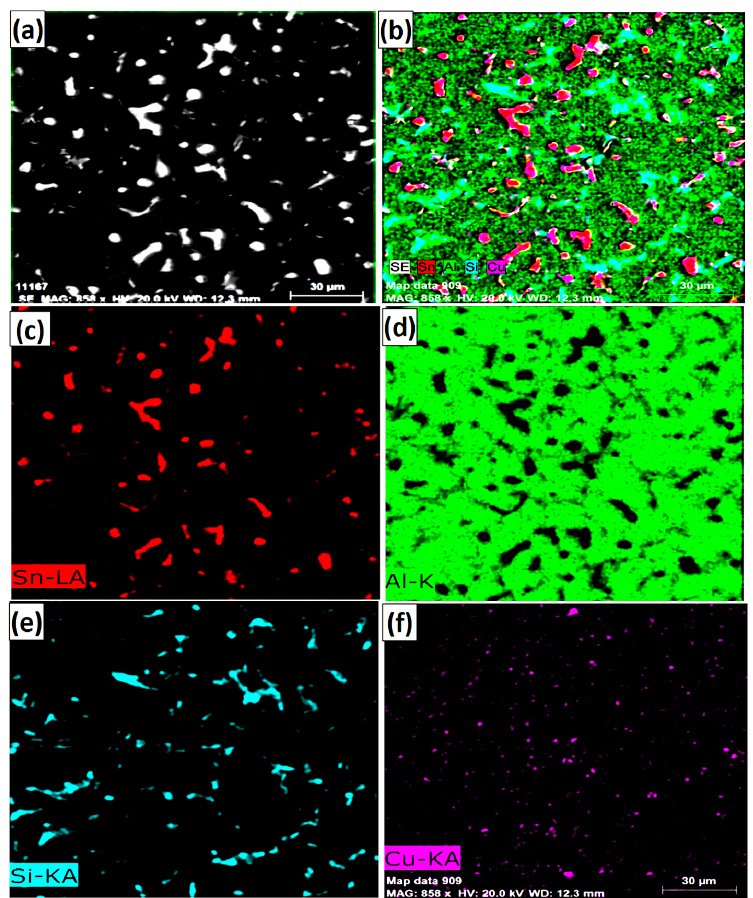
Figure 3. ( a , b ) SEM images, ( c ) EDS and ( d – f ) mapping analysis of Al-based bearing alloy.